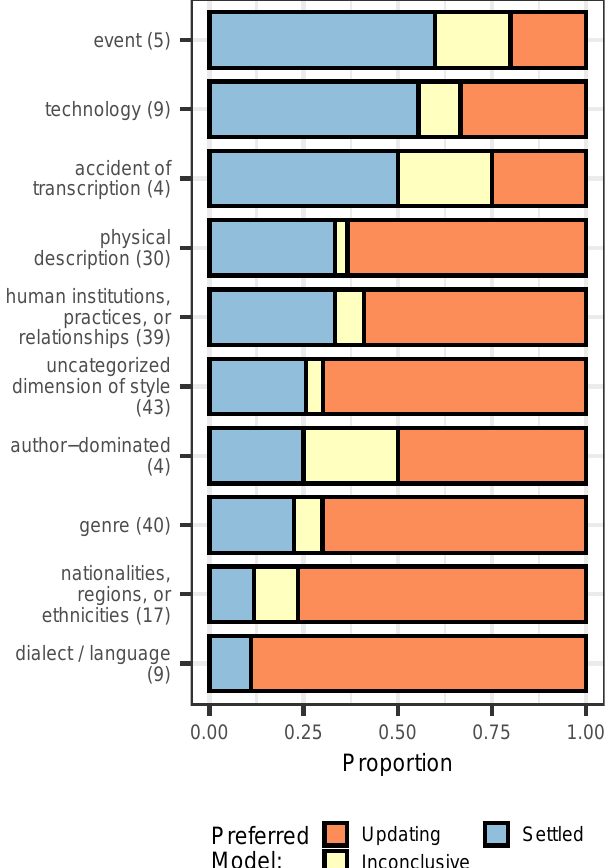
Figure 4: Proportion of topics favoring updating and settled models, by topic category. Total n = 200, each estimated on 1,714 unique authors with 6,927 unique triples. Topics favor the updating model when changes in between two consecutive books persist to a